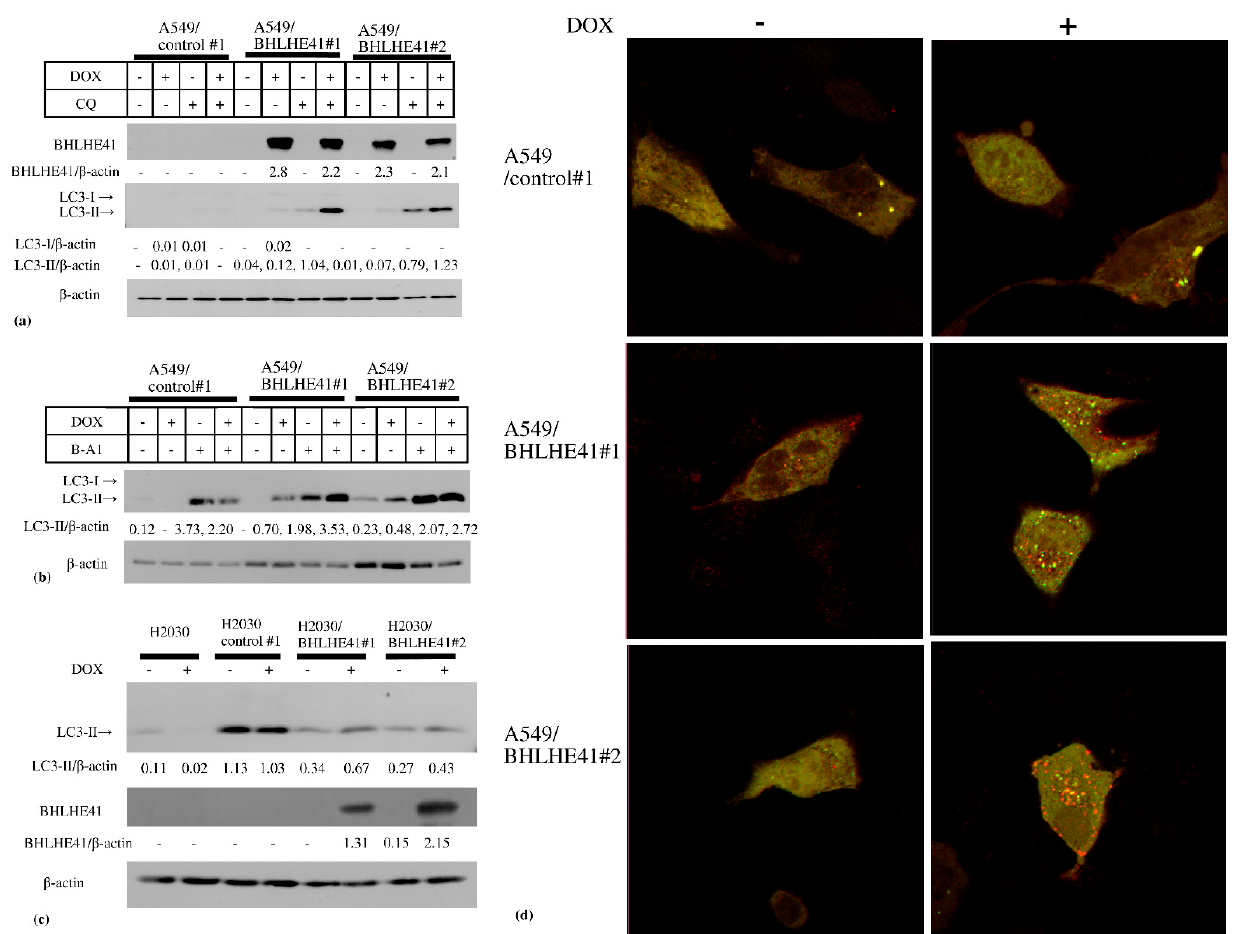
Figure 5. Immunoblotting of autophagy-related proteins. Immunoblotting of autophagy-related proteins. ( a ) In A549 and derived cells, DOX induced the accumulation of LC3-II and CQ enhanced this accumulation. ( b ) In A549 and derived cells, DOX induced the accumulation of LC3-II and 5 nM bafilomycin A1(B-A1) treatment increased LC3-II accumulation. ( c ) In H2030 and derived cells DOX could increase LC3-II accumulation. ( d ) Merged photo of GFP and mRFP photos of fluorescence-tagged LC3 expression of A549/control#1, A549/ BHLHE41#1, and A549/BHLHE41 #2 transiently transfected with the ftLC3 plasmid and observed via confocal laser microscopy, after incubation with medium with or without DOX (0.5 μ g/mL) for 48 h. The red spots indicate autophagosomes that is not fused with lysosomes and the yellow spots are autophagosomes fused with lysosomes.